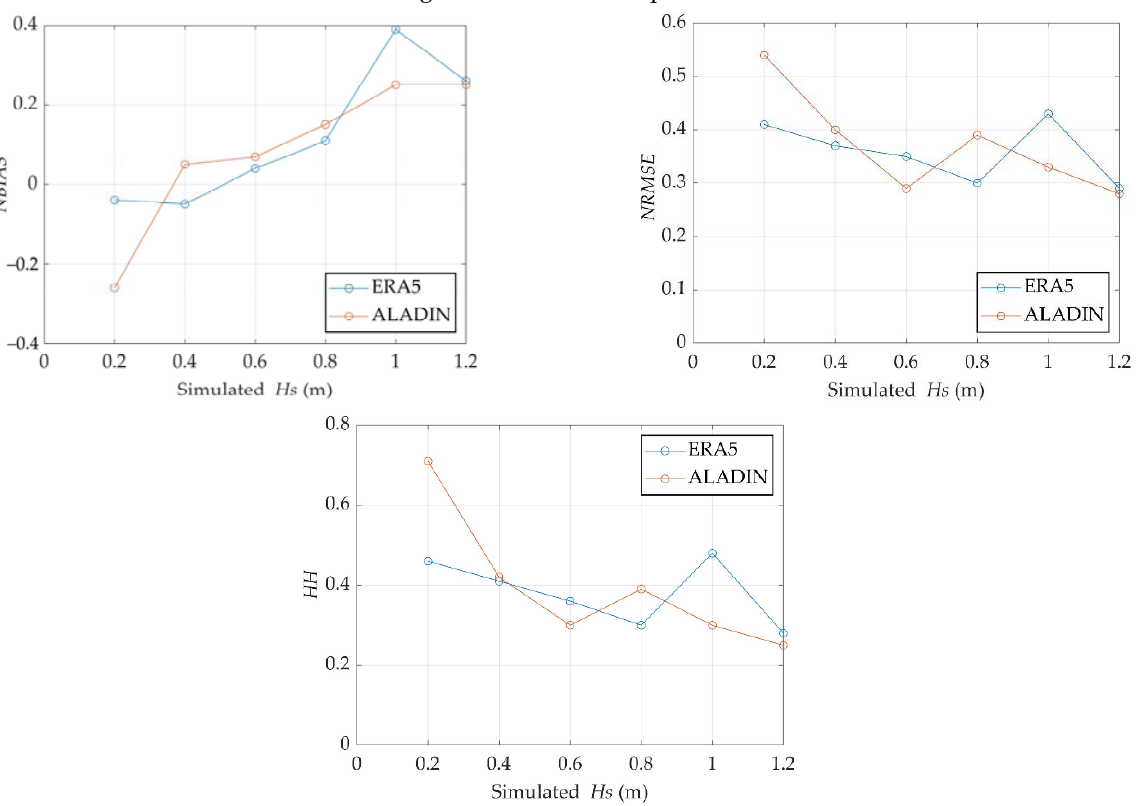
Figure 9. Plots showing the relationship between the simulated significant wave heights (forced by ERA5 (blue) and ALADIN (orange) reanalysis wind data) and various performance metrics (HH, NRMSE, NBIAS) for the simulation period.